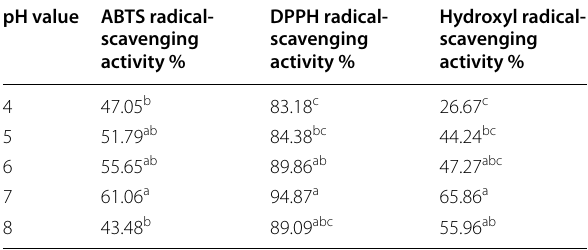
Where the data are the means of triplicate experiments; samples in the same column with different superscript letters are significantly different (P < 0.05) a value is the highest antioxidant activity, b value is the medium antioxidant activity and c value is the lowest antioxidant activity in the same column